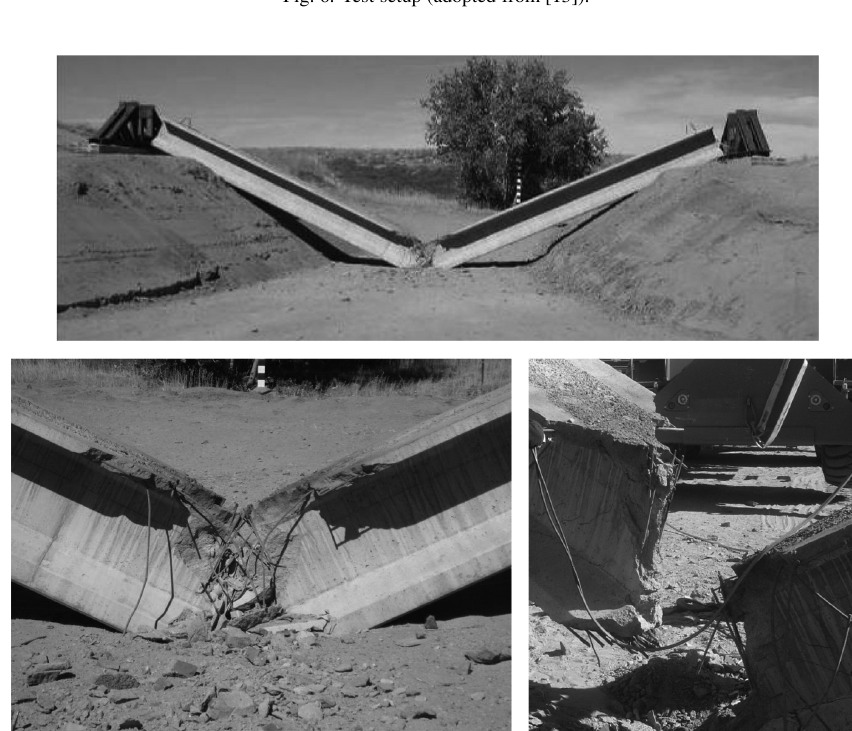
Fig. 7. Damaged girder from blast above midspan (adopted from